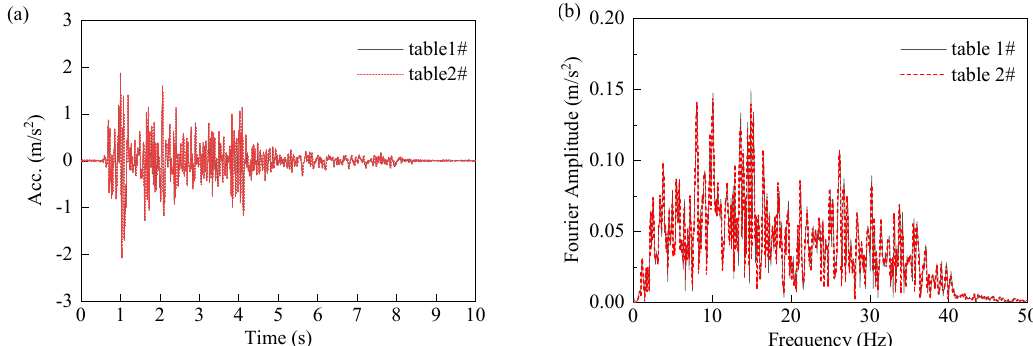
Figure 11. Measured accelerations of two tables subjected to uniform ScEL (Case1) ( a ) Time history ( b ) Fourier Amplitude.